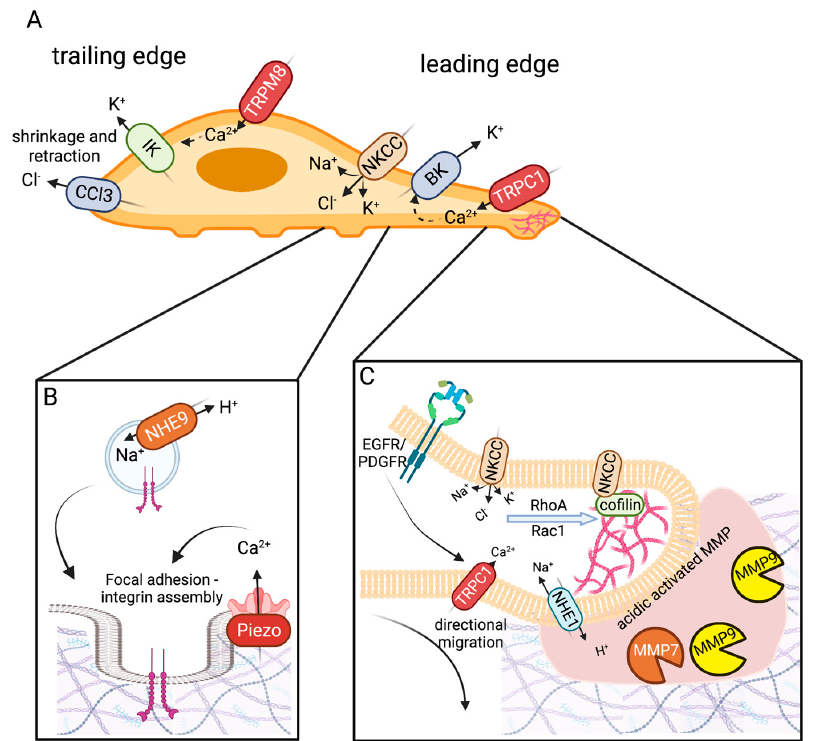
Figure 2. Ion channels mediating glioma infiltration and mesenchymal migration. ( A ) Migrating cells have a leading and trailing edge. The trailing edge shrinks and retracts, mediated by IK and CLC3 ion channels. The leading-edge swells (mediated by BK channels) establish focal adhesions (PIEZO and NHE9) for traction and utilizes F-actin polymerization (NKCC) to establish new cellular territory. ( B ) Focal adhesions assembly involves localization and clustering of β -integrin to the plasma membrane. NHE9 acts as a H + leak establishing a pH state important for endosomal protein trafficking of β -integrin. Focal adhesion formation is promoted by PIEZO1-mediated mechanosensa- tion. This contributes to glioma stiffening that creates a feedback loop promoting glioma migration and metastasis. ( C ) The leading edge of migrating cells with invadopodium express NHE1, which acidifies the extracellular matrix (ECM)-activating matrix metalloproteinases MMP-7 and MMP-9. MMPs break down the ECM to allow migrating glioma cells to invade new territory. NKCC restores K + and Cl − levels following cell shrinkage. It also activates cytoskeletal remodeling of the leading edge by promoting the actions and localization of RhoA, Rac1, and Cofilin. NKCC-mediated actin polymerization is important for lamellipodium extension and directional migration in response to chemotaxis. Growth factors EGF and PGDF act as chemoattractants via activation of EGFR/PDGR signaling. Their downstream effects promote localization of TRPC1 (and likely other TRPC channels) which is thought to influence directional migration. Created with